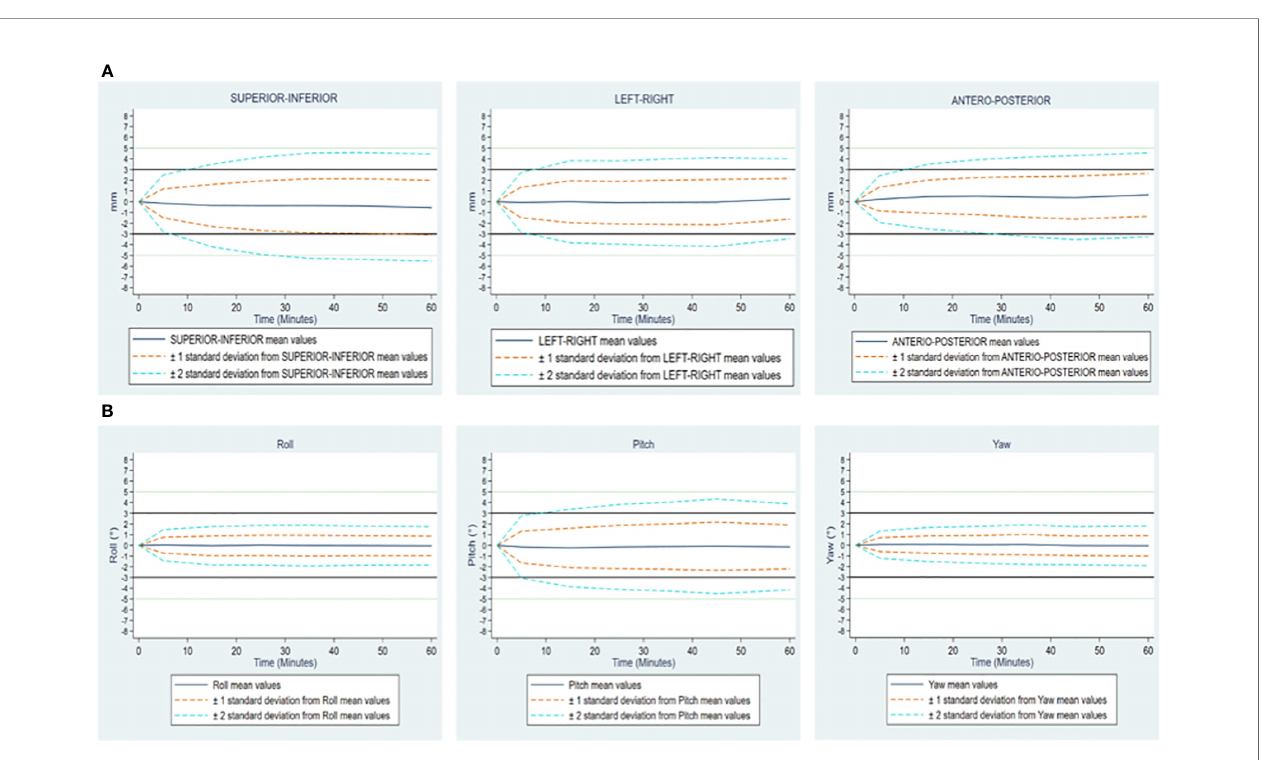
FIGURE 3 | (A) Translational motions Supero-Inferior, left-Right and antero-posterior expressed in mm. (B) Rational motions Roll, Pitch and Yaw expressed in degrees. Changes over time of translational and rotational motions of the prostate, in all patients. On each fi gure, mean values and standard deviations, by 10-minute time interval, overall considering both groups